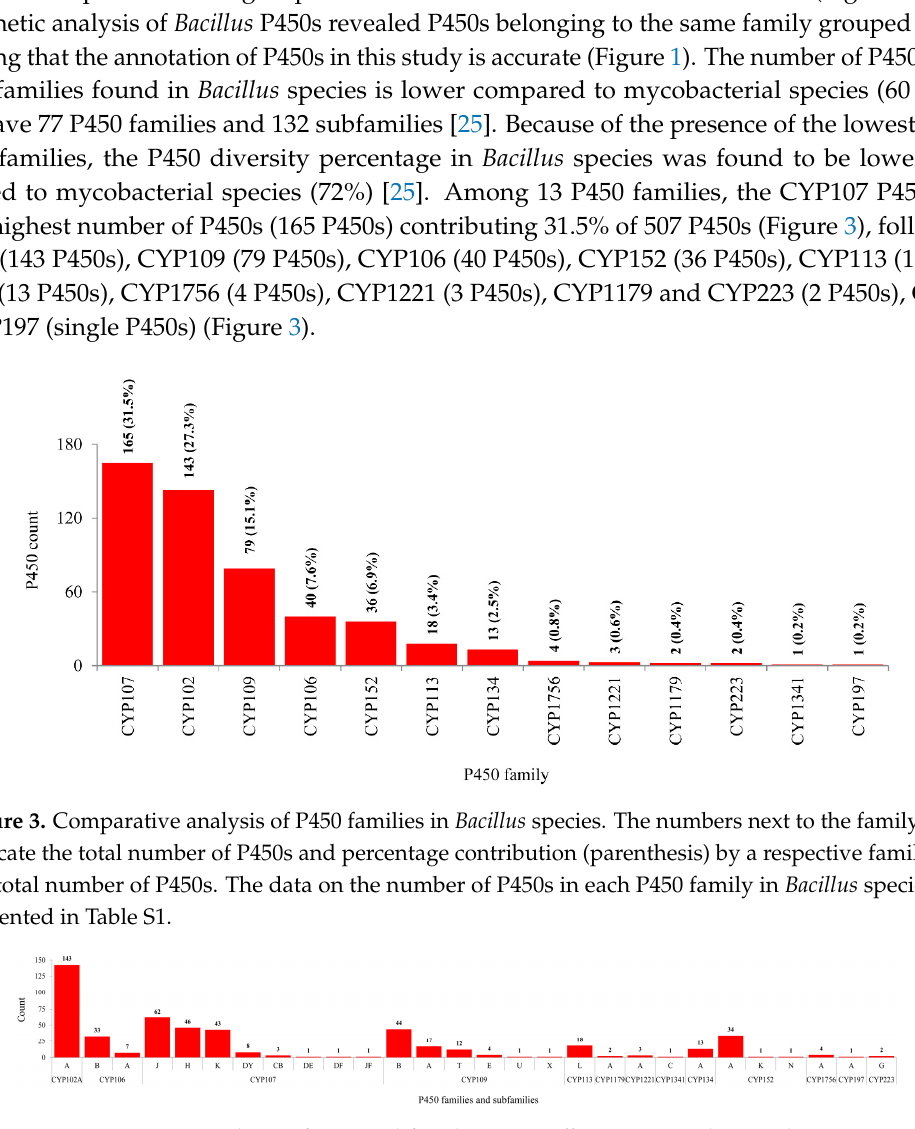
Figure 4. Comparative analysis of P450 subfamilies in Bacillus species. The numbers next to bars indicate the total number of members in a particular subfamily. Data on the number of P450s in each P450 subfamily in Bacillus species is presented in Table S1.